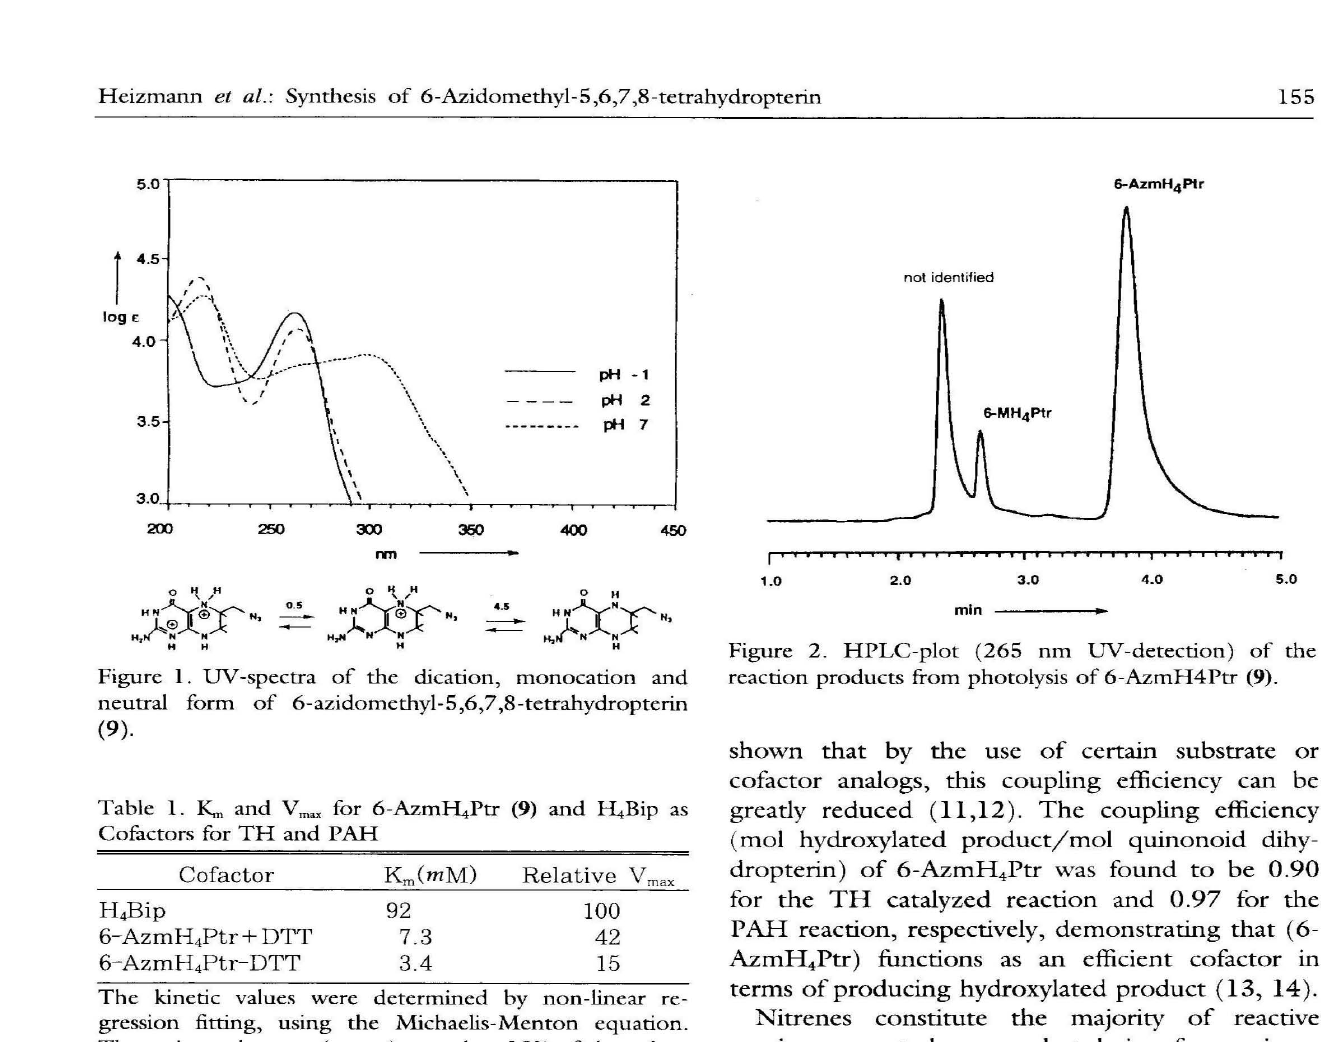
Figure 1. UV-spectra of the dication, mono cation and neutral form of 6-azidomethyl-5,6,7,8-tetrahydropterin (9).